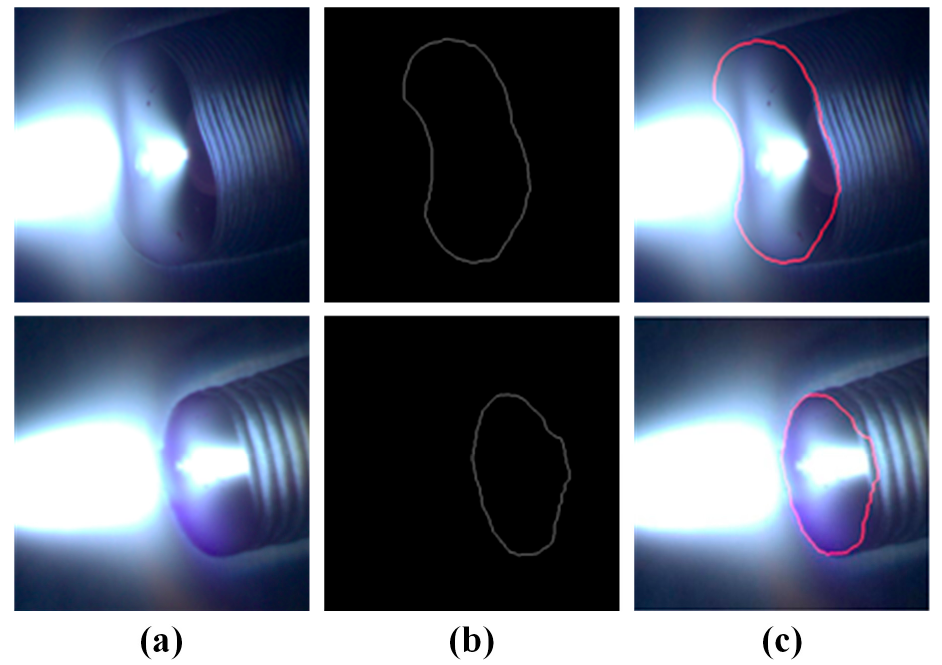
Figure 1. The effect of traditional image algorithm: ( a ) molten pool image; ( b ) contour extracted by traditional algorithm; ( c ) contour superimposed on molten pool image.